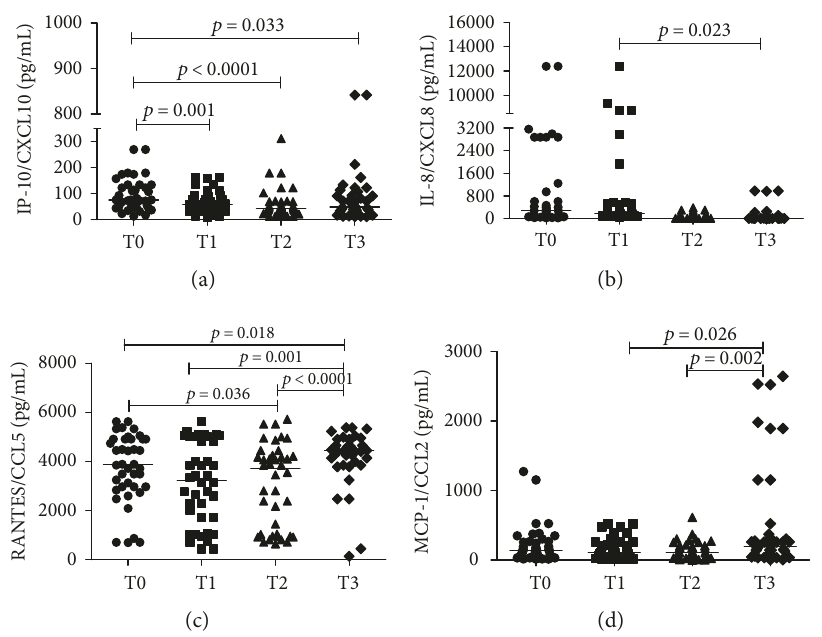
Figure 2: Plasma levels of CXCL8/IL-8, CXCL10/IP-10, CCL5/RANTES, and CCL2/MCP-1 in preterm infants ( N = 40 ) at four di ff erent time points (T0: umbilical cord blood, T1 48 hours, T2: 72 hours, and T3: 3 weeks after birth). CBA was used in ex vivo analysis. Mann – Whitney test was used for comparisons between medians of patients with normal motor development versus patients of lower than expected motor development.